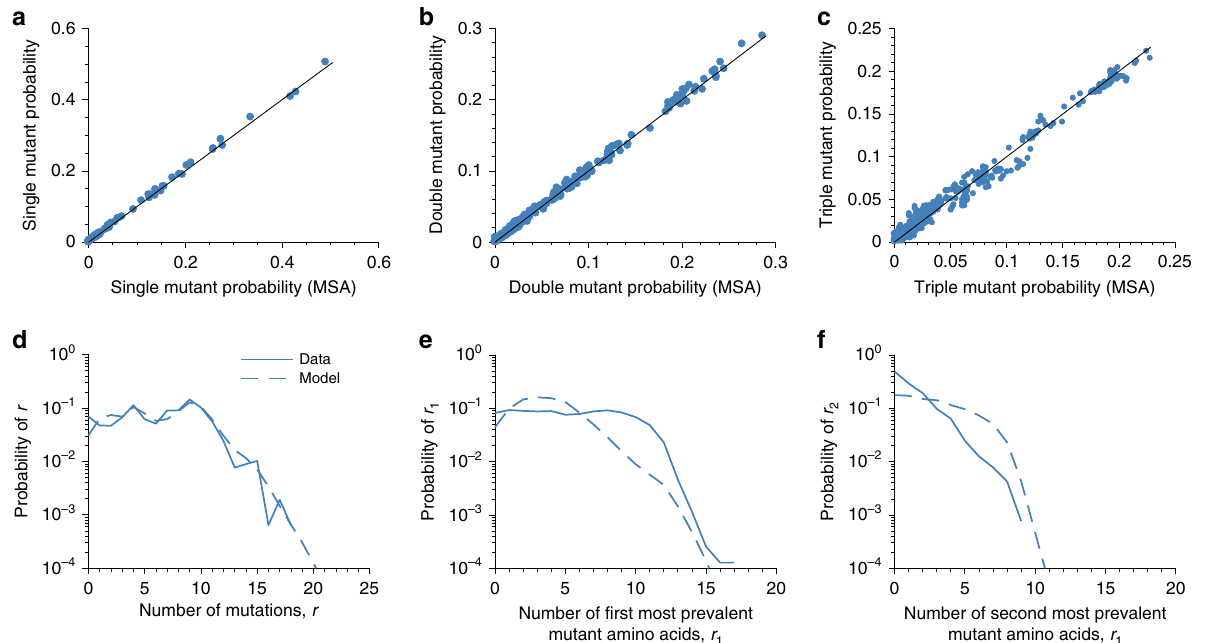
Number of second most prevalent mutant amino acids, r 1 Fig. 1 The inferred Potts model accurately captures the single and double mutant probabilities, as well as the higher order statistics of the observed sequences. a , b Comparison of the data statistics used to train the model: a the single mutant probability, and b the double mutant probability of the observed sequences and of those obtained from the inferred Potts model. c – f Comparison of the data statistics predicted by the inferred Potts model: c the triple mutant probability, d the distribution of the number of mutations, e the distribution of the fi rst most-prevalent mutant amino acid, and f the distribution of the second most-prevalent mutant amino acid in the observed sequences and the inferred Potts model. For model prediction related to connected correlations in the data, i.e., the correlations which cannot be explained by lower order mutant probabilities, see Supplementary Fig.